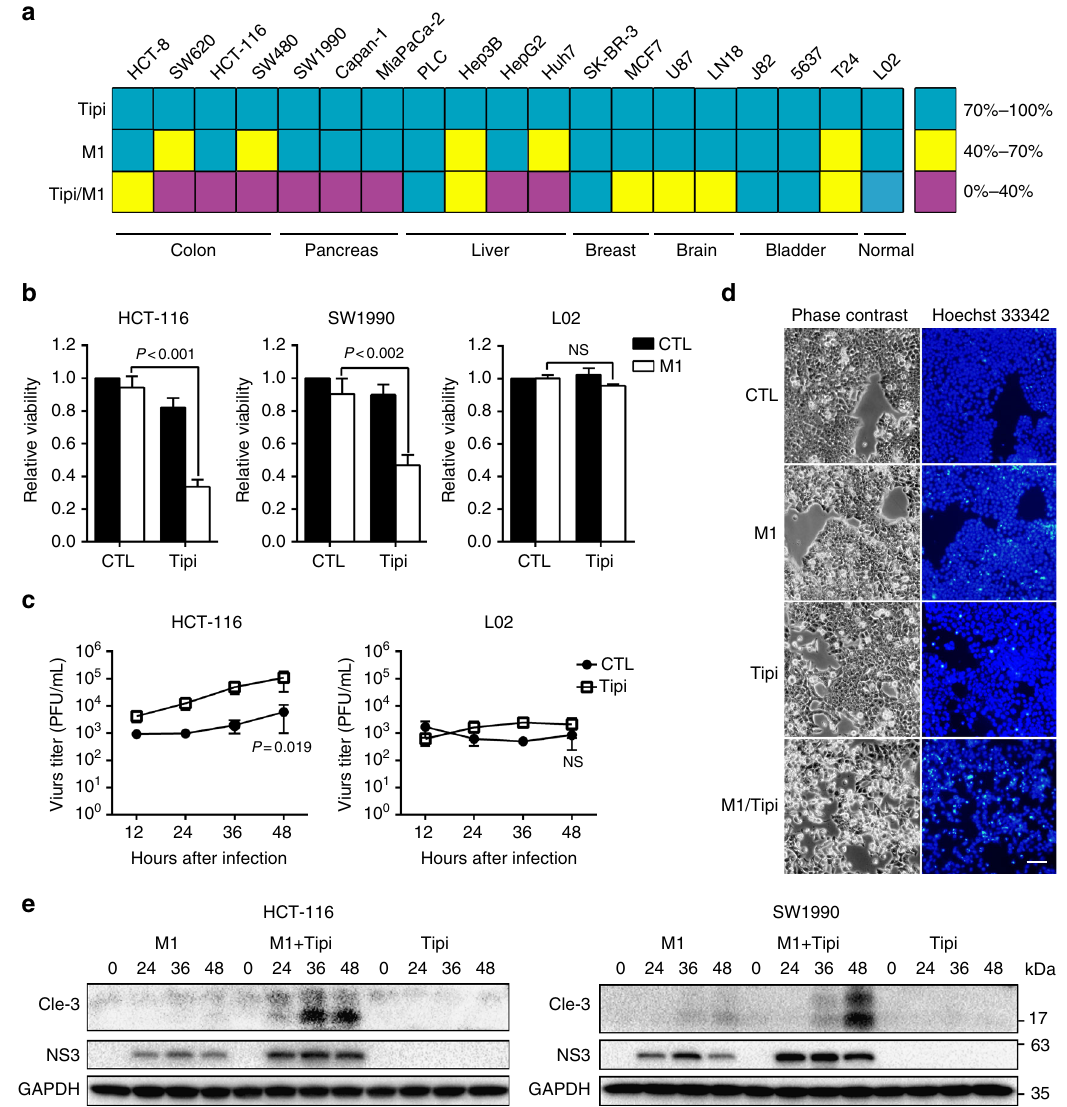
Fig. 5 Farnesyl transferase inhibitor potentiates the oncolytic ef fi cacy of M1 virus in vitro. a Cells were treated with vehicle, Tipifarnib (50 nM), M1 (MOI = 1), or Tipifarnib /M1. Cell viability was determined with MTT assay 72 h after M1 virus infection. n = 2. b HCT-116, SW1990, and L02 cells were treated with vehicle, Tipifarnib (50 nM), M1 (MOI = 1), or Tipifarnib /M1. Cell viability was determined with MTT assay 72 h after M1 virus infection. n = 3. Data shown in b , c were the mean ± SEM. Statistical signi fi cance was using one-way ANOVA. n.s. represents no signi fi cance. c HCT-116 and L02 cells were treated with vehicle or Tipifarnib (50 nM), and infected with M1 virus (MOI = 0.1). Virus supernatants are collected 12, 24, 36, 48 h after infection. Virus titer of samples was measured by TCID50 assay. n = 4. Statistical signi fi cance was using t -test, two-sided. d HCT-116 cells were treated with vehicle, Tipifarnib (50 nM), M1 (MOI = 1), or Tipifarnib /M1 for 48 h, Hoechst 33342 staining was used to detect nucleus. Scale bar: 100 μ m. n = 2. e HCT-116 and SW1990 cells were treated with Tipifarnib (50 nM), M1 (MOI = 1), or Tipifarnib /M1 for 24, 36, 48 h. M1 Virus protein NS3 and apoptosis executor cleaved-caspase3 (Cle-3) were detected by western blotting. n =